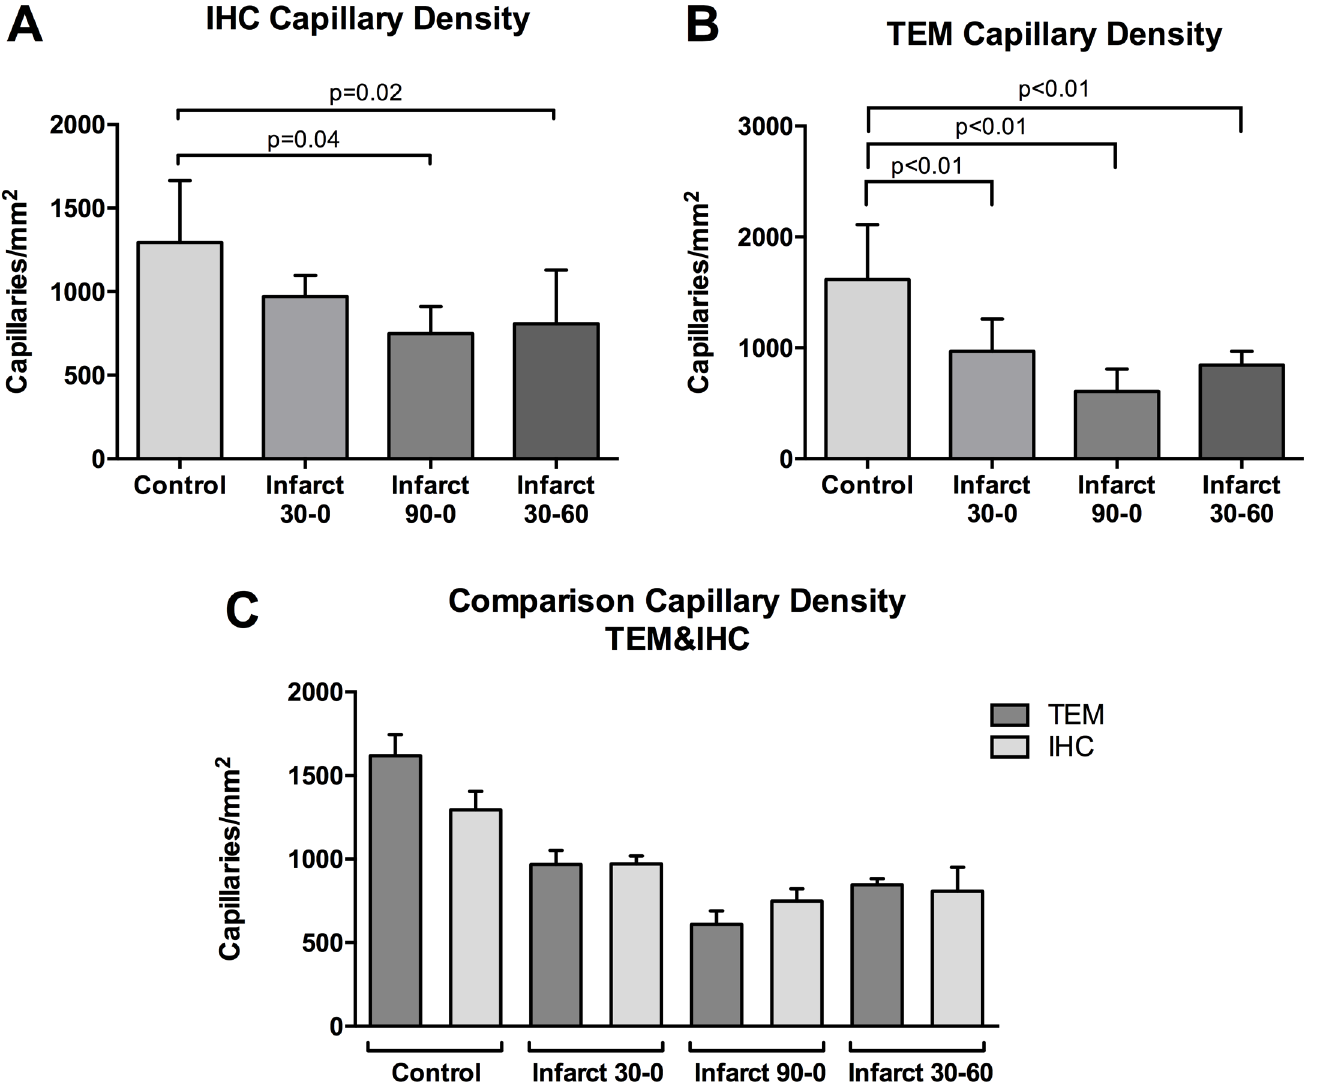
Fig 2. Capillary density. Immunohistochemical analysis of frozen tissue samples. A Quantification of capillary density by immunohistochemistry (IHC). B Quantification of capillary density by Transmission Electron Microscopy (TEM). C Comparison of capillary density between TEM and IHC. Capillary density is expressed as the number of capillaries per square